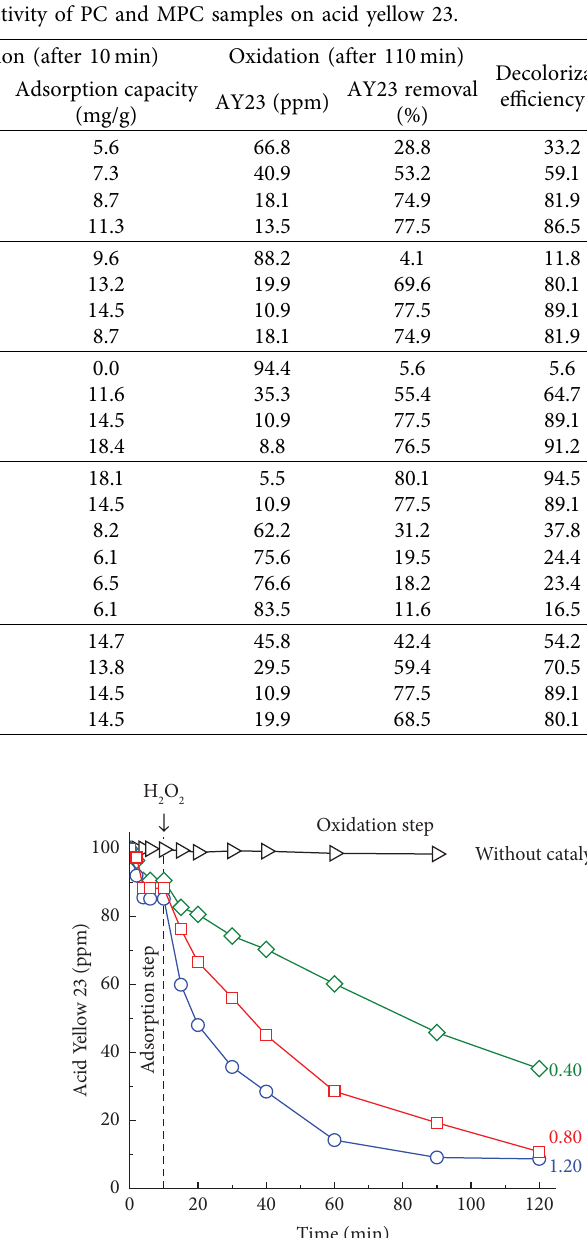
Figure 13: Efect of MPC dosage on AY23 decolorization (MPC- 3 / R0.1-2.0 h, pH 3.0, and 200 ppm H 2 O 2